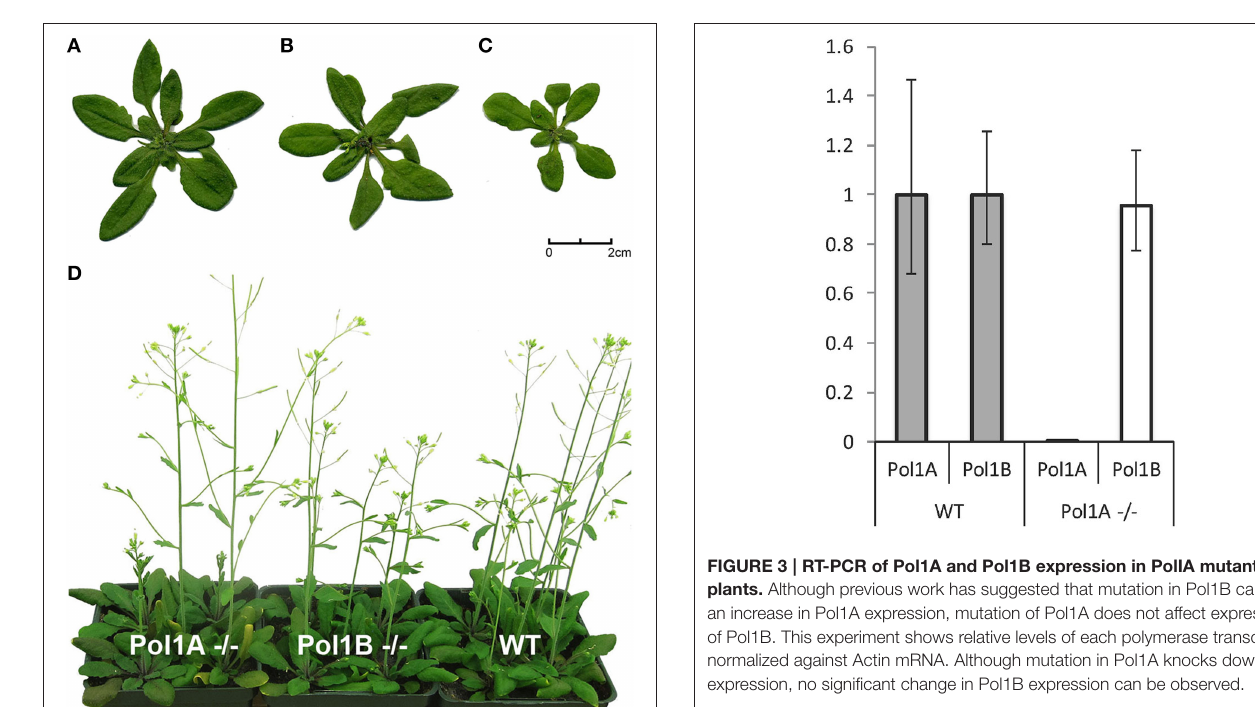
Schmid et al., 2005). Coexpression data (ATTED-II) indicates